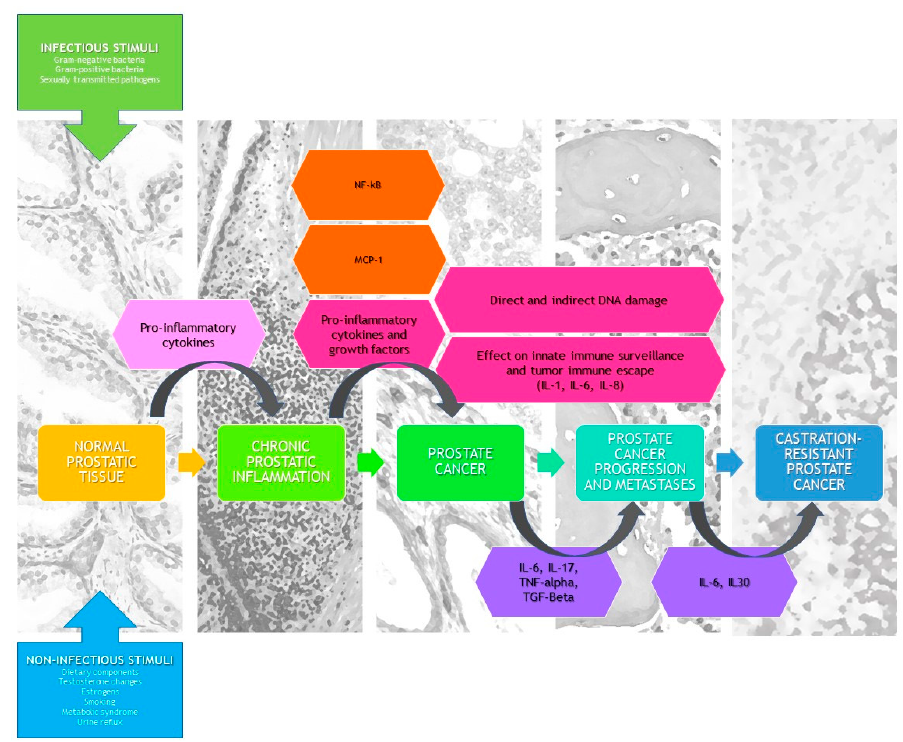
Figure 4. Impact of prostatic inflammation and inflammatory mediators on tumor initiation, growth and progression. NF-kB: Nuclear Factor-kappa B.